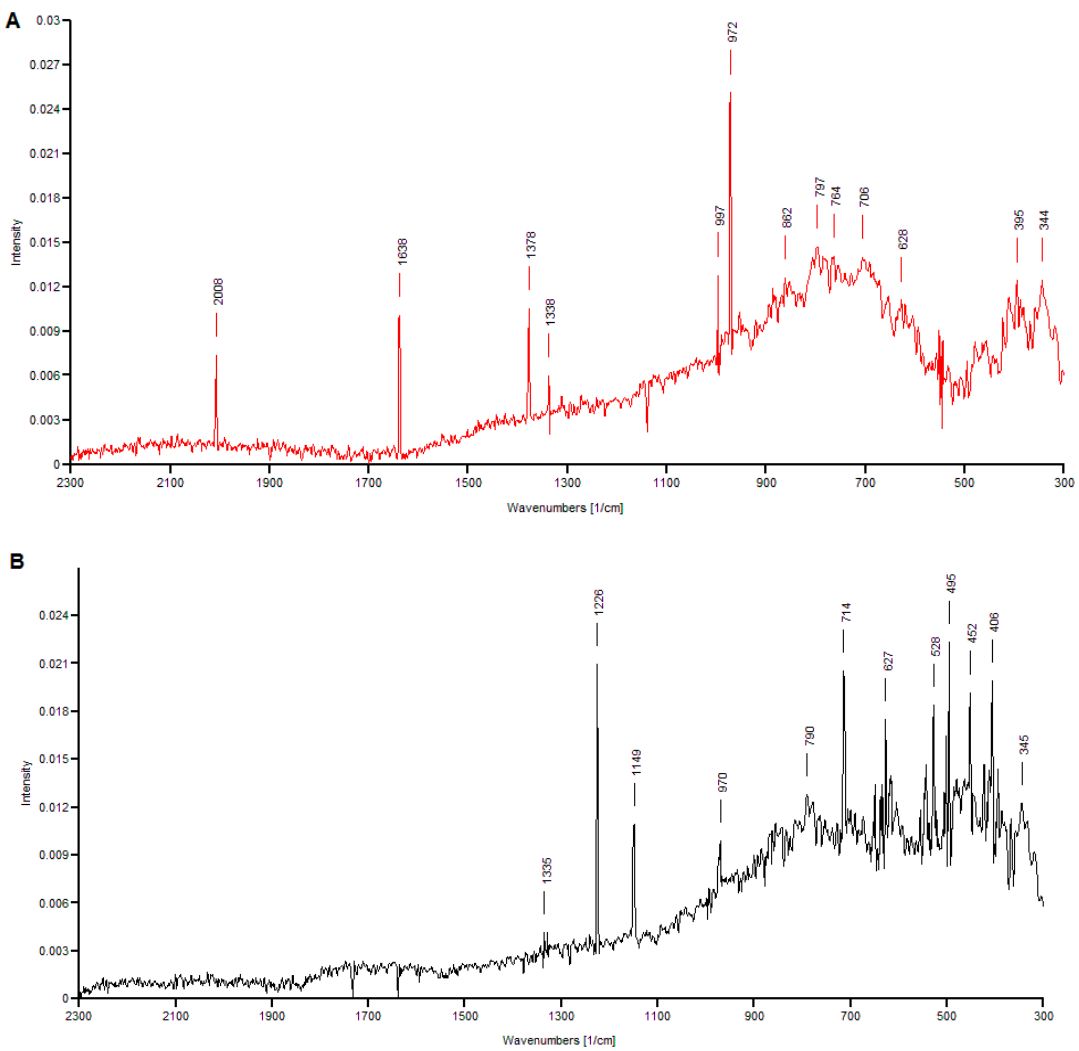
Figure 5. Raman spectra of extracts with 2-propanol ( A ) and methanol ( B ).